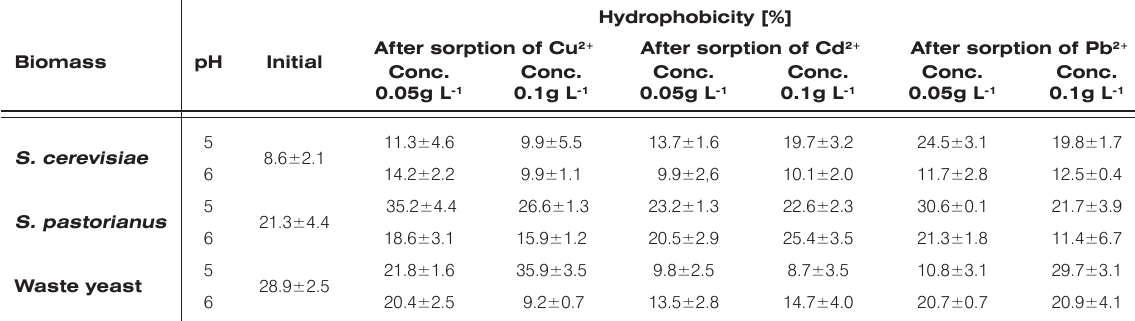
Table 2. The relative hydrophobicity of different biomass measured after biosorption of Cu 2+ , Cd 2+ , Pb 2+ from solutions at 0.05g L -1 and 0.1g L -1 concentration at pH = 5 and pH = 6.